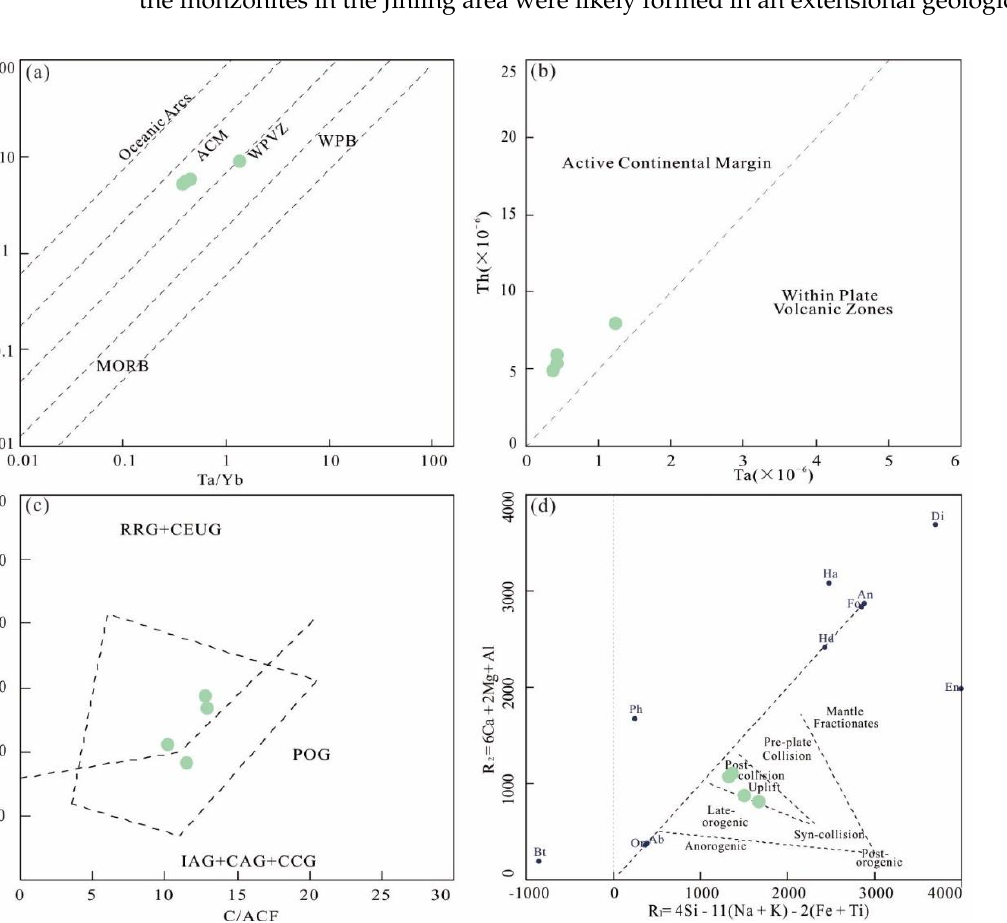
Figure 10. The tectonic setting of the quartz monzonites in the Jiling area, western Shandong province, ( a ) — the diagrams of Ta/Yb – Th/Yb, ( b ) — the diagrams of Ta – Th, ( c ) — the diagrams of C/ACF – F/ACF, ( d ) — the diagrams of R 1 – R 2 .